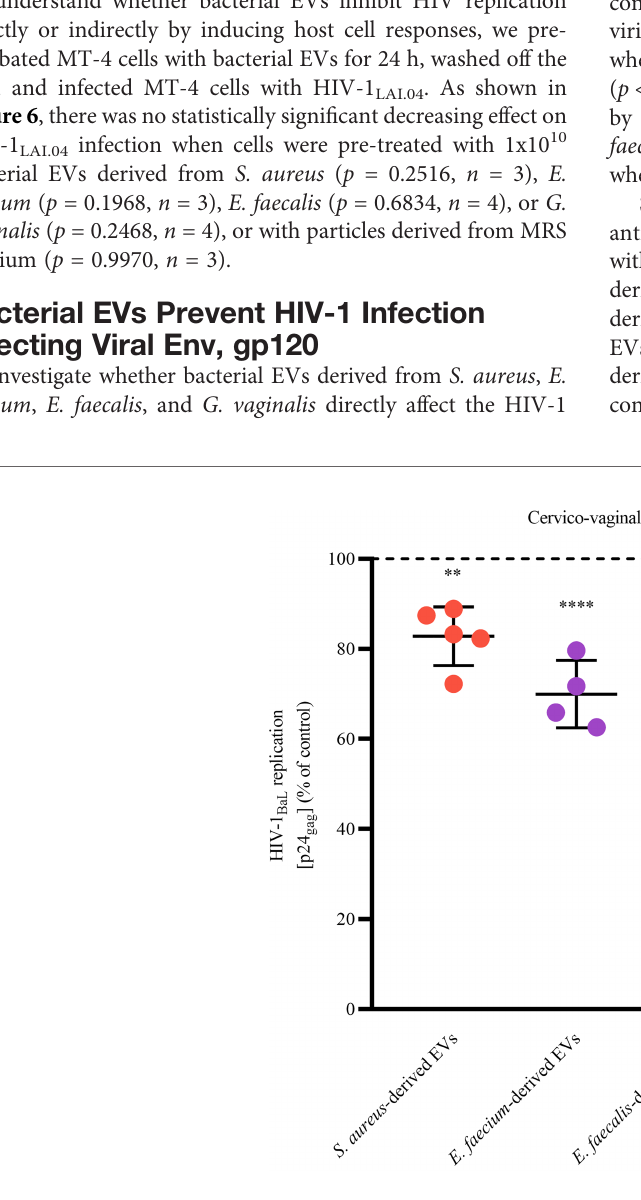
FIGURE 5 | Anti-HIV-1 effect of bacterial EVs in human cervico-vaginal tissues ex vivo . Cervico-vaginal tissue blocks were infected with EV-pretreated HIV-1 BaL and cultured for 12 days, with replacement every 3 days of tissue culture medium containing or not containing 1×10 10 EVs/mL derived from S. aureus , E. faecium , E. faecalis , and G. vaginalis . Replication of HIV-1 was evaluated from measurements of the capsid protein p24 gag in tissue culture medium and is represented as a percentage of HIV-1 replication in untreated control. Presented are means±SEM from tissues of at least four donors. Asterisks indicate statistical signi fi cance by one-way ANOVA multiple comparison with Dunnett ’ s correction (**p<0.01,